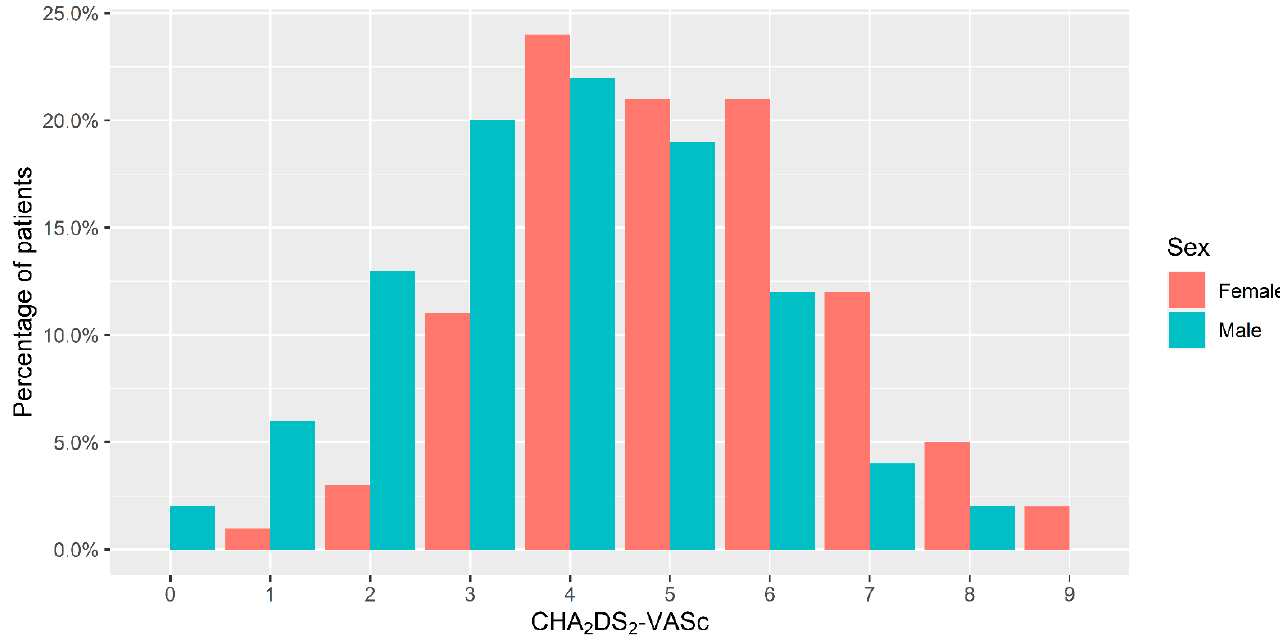
Figure 1. Flowchart of patients with atrial fibrillation in the study.